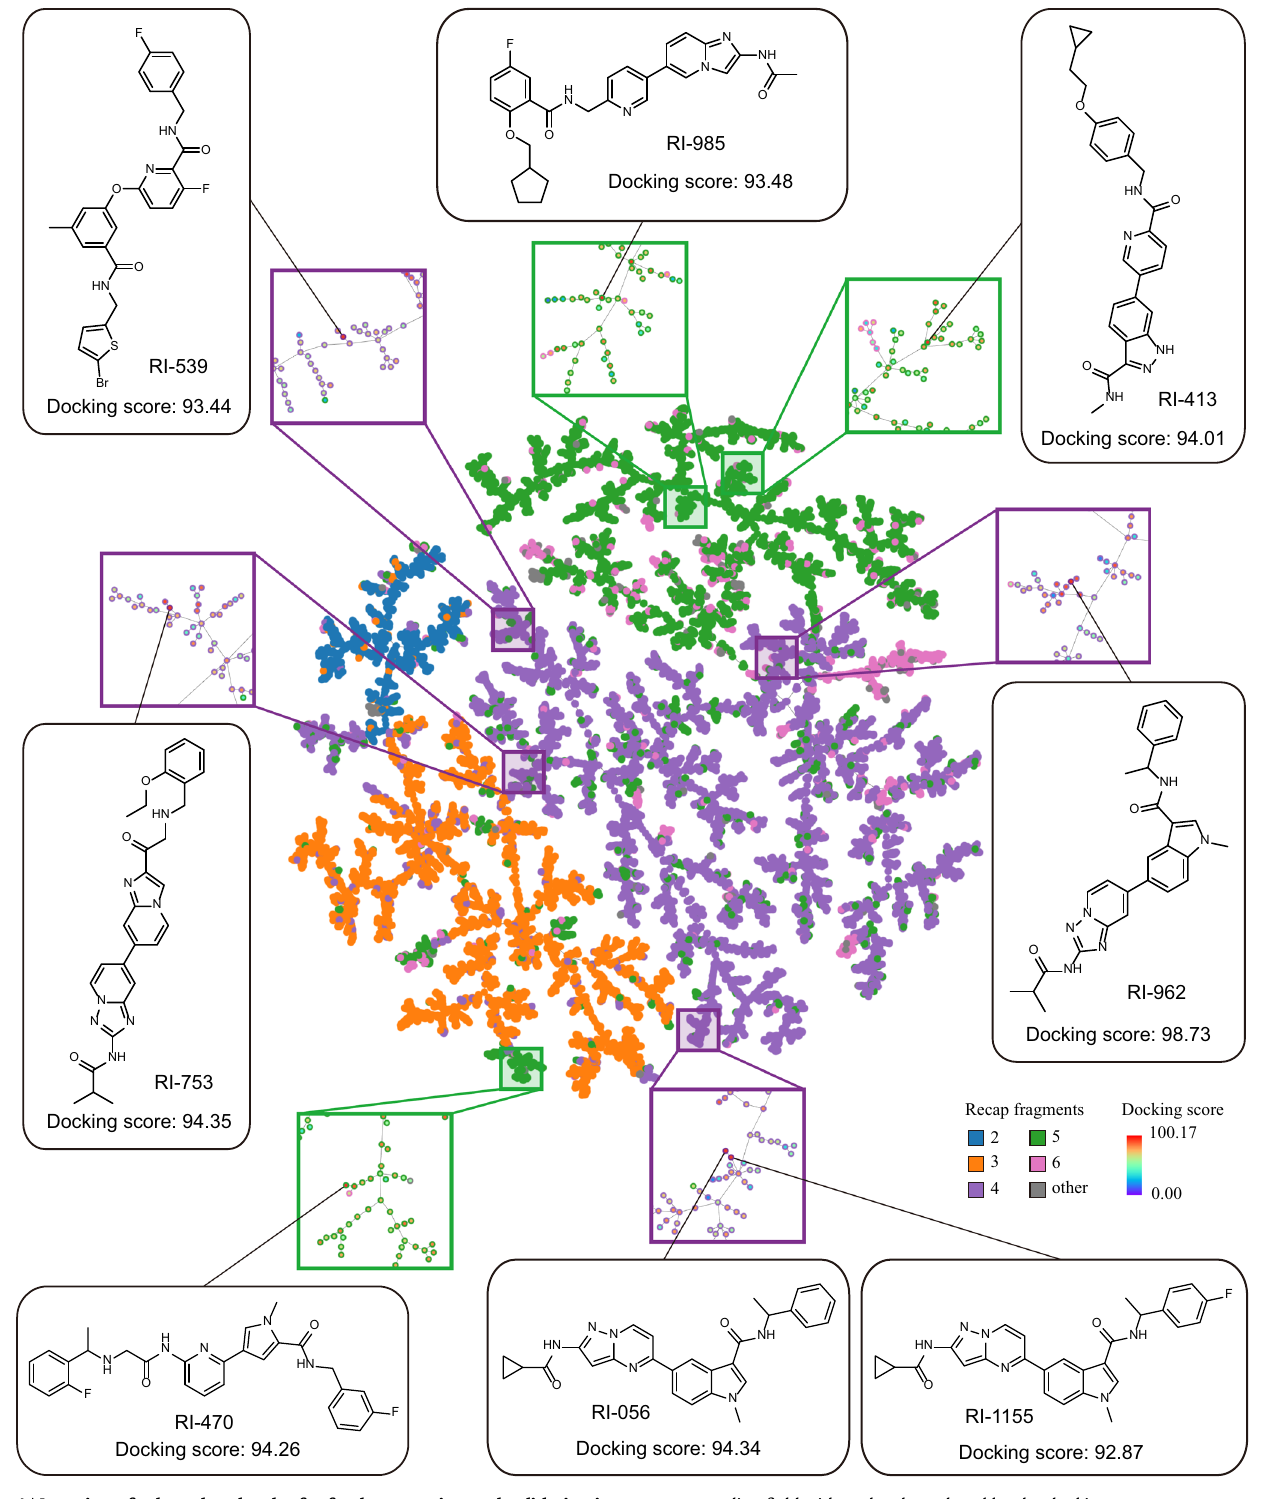
corresponding fi eld with molecules colored by the docking score (red – yellow – green).Moleculeswithdockingscores:selectedmoleculespointingto their position in the